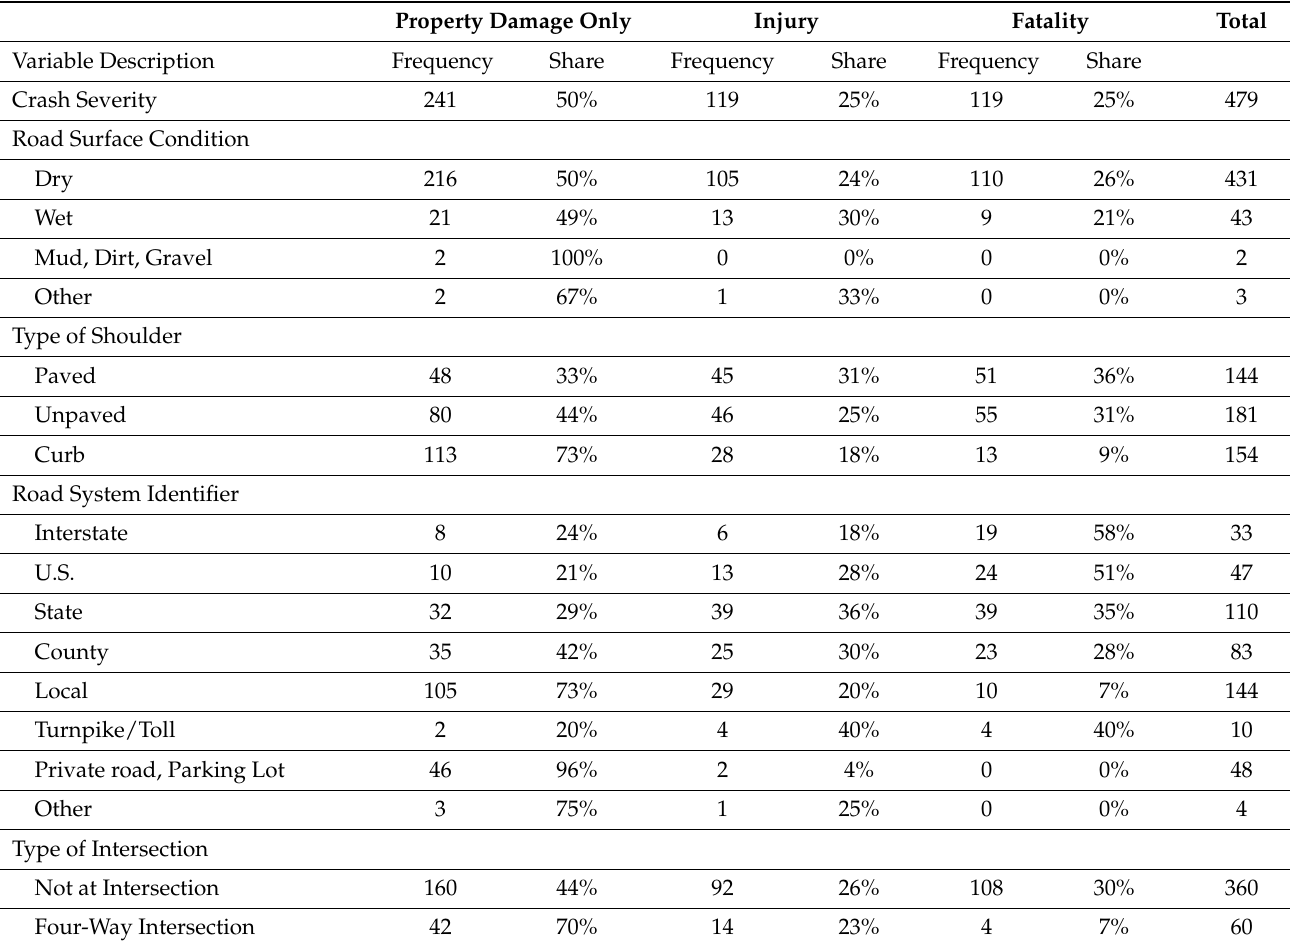
Table 2. Crash Data